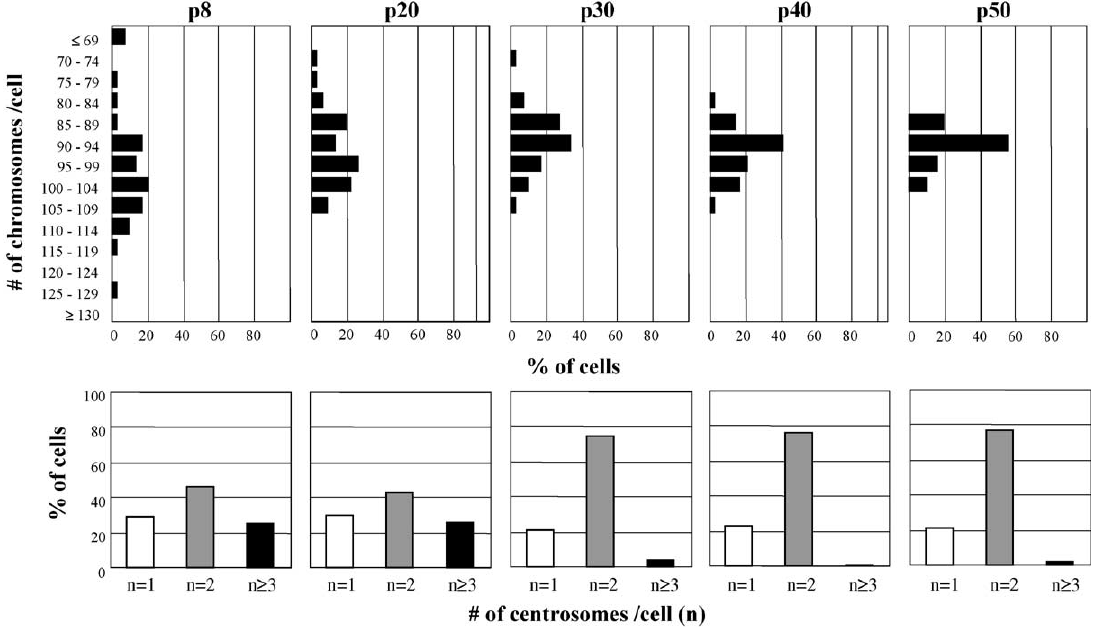
Fig. 2. Karyotypic convergence of p53 − / − MEEs in culture is accompanied with restoration of normal centrosome profiles.